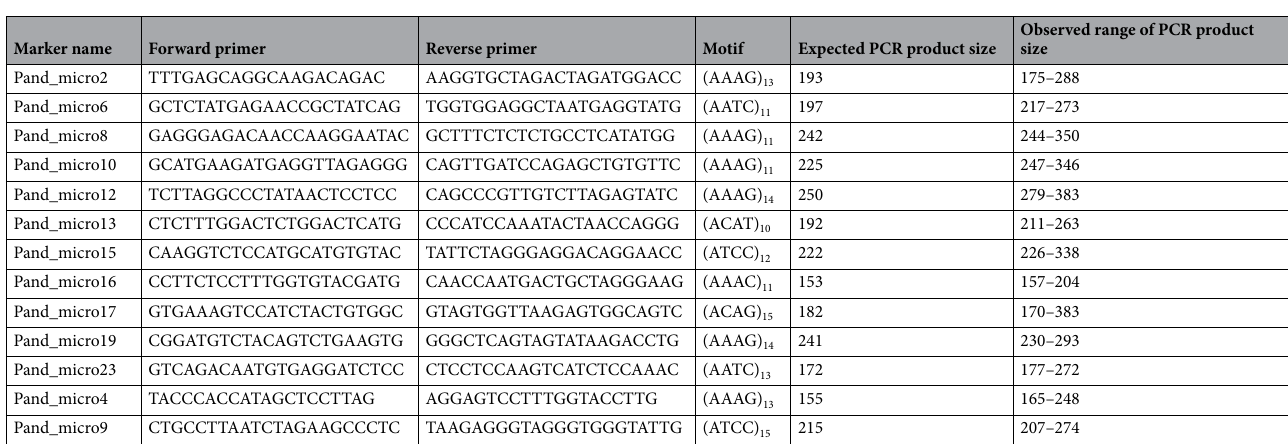
Table 1. New Andaman day geckos ( Phelsuma andamanensis ) microsatellite primers Forward primer and reserve primer columns provide the primer sequence and Motif shows the 4 bp repeat motif of each locus. PCR product size is the expected value from the primer design